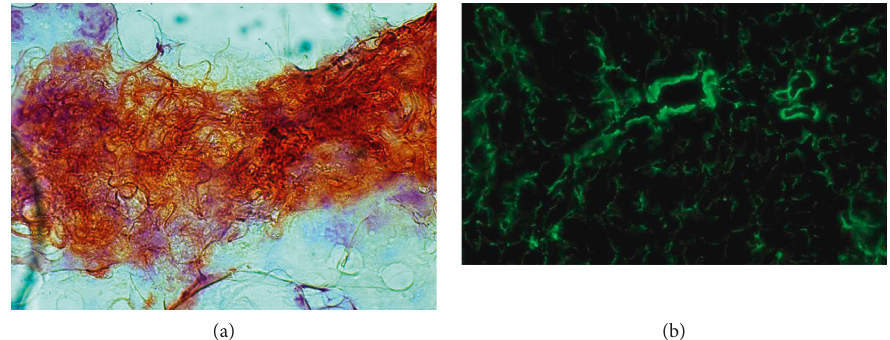
Figure 3: Amyloid deposition in periumbilical fat ((a)-Congo red) with apple-green birefringence (b) at polarized microscope